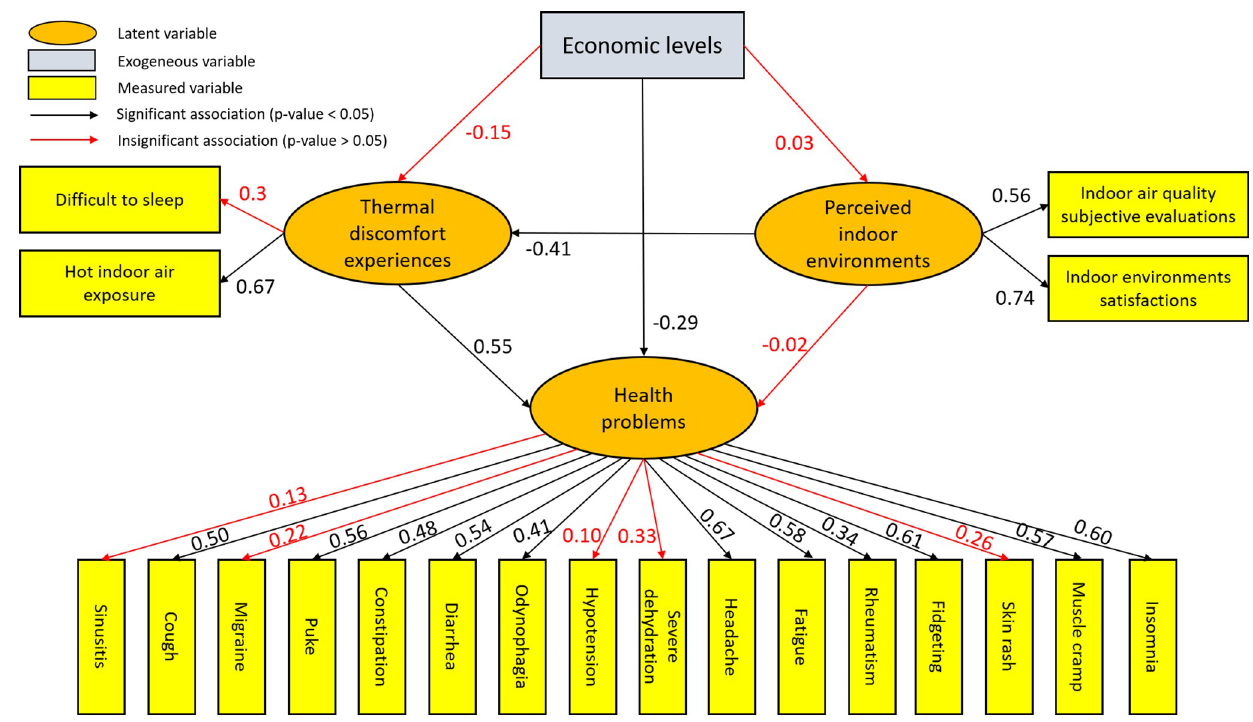
Fig 5. Standardized estimates of the associations between economic levels, thermal discomfort experiences, perceived indoor environments, and health problems.